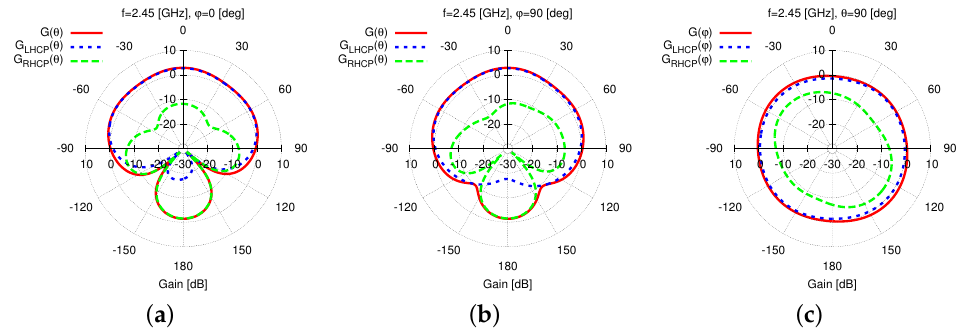
Figure 5. Numerical Assessment ( [ f min , f max ] = [ 2.3, 2.6 ] [GHz], f = f 0 = 2.45 [GHz])—Total, G ( f 0 , θ , ϕ ) , LHCP , G LHCP ( f 0 , θ , ϕ ) , and RHCP , G RHCP ( f 0 , θ , ϕ ) , gain patterns for elevation cuts